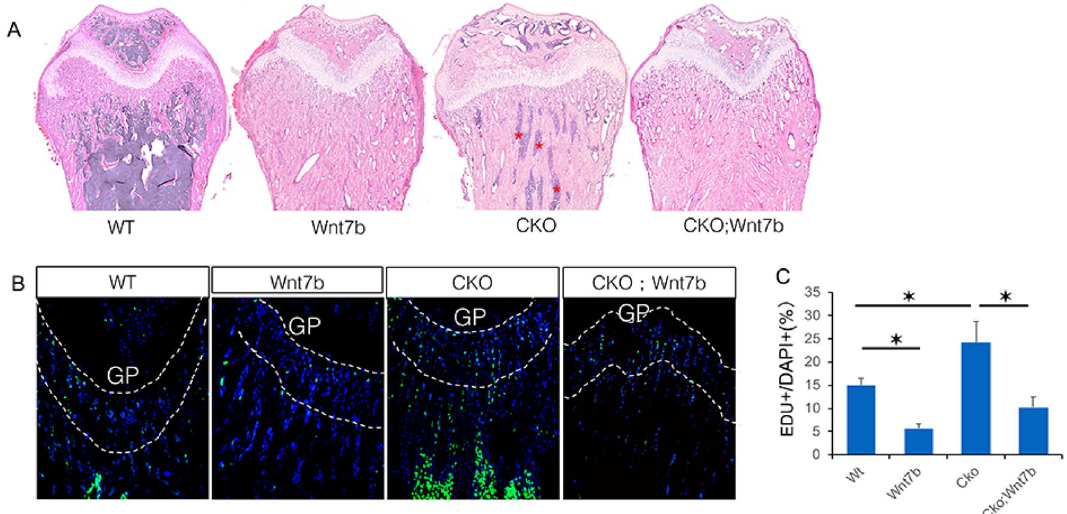
Figure 4. Wnt7b overexpression reduces cell proliferation in trabecular bone region. ( A ) Representative images of H&E-stained sections of the distal femur at P33. ( B ) Representative images of the distal femur labeled with EdU at P33. EdU signal is in green and DAPI nuclei staining in blue. ( C ) EdU labeling index at the chondro- osseous junction of distal femur (100 µm region immediately below the growth plate). *: P < 0.05, two-way ANOVA, n = 3 (females). GP: growth